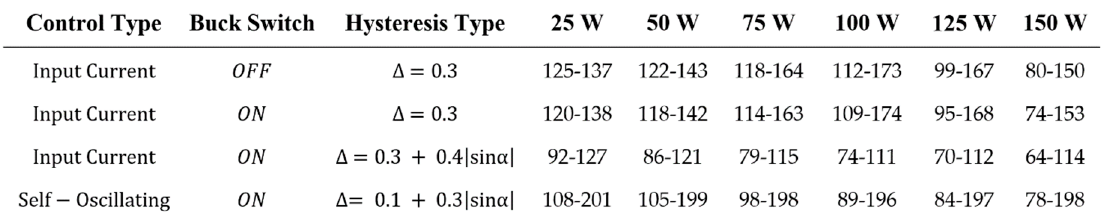
Figure 29. Microinverter efficiency in %.